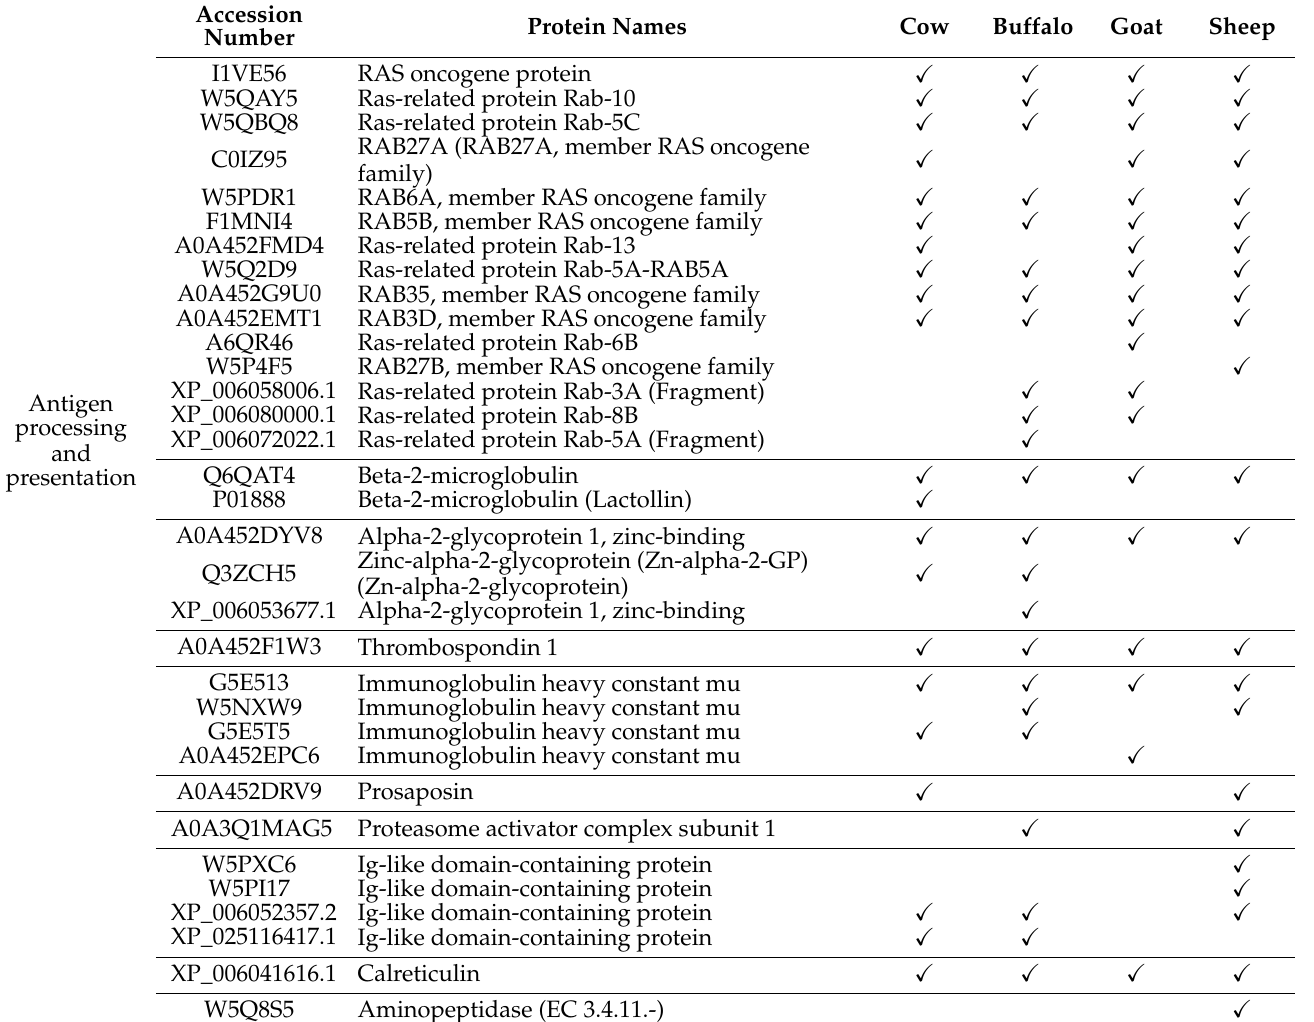
Table 2. Proteins identified in cow, buffalo, goat and sheep cream in the biological process GO terms “Antigen process and presentation”.